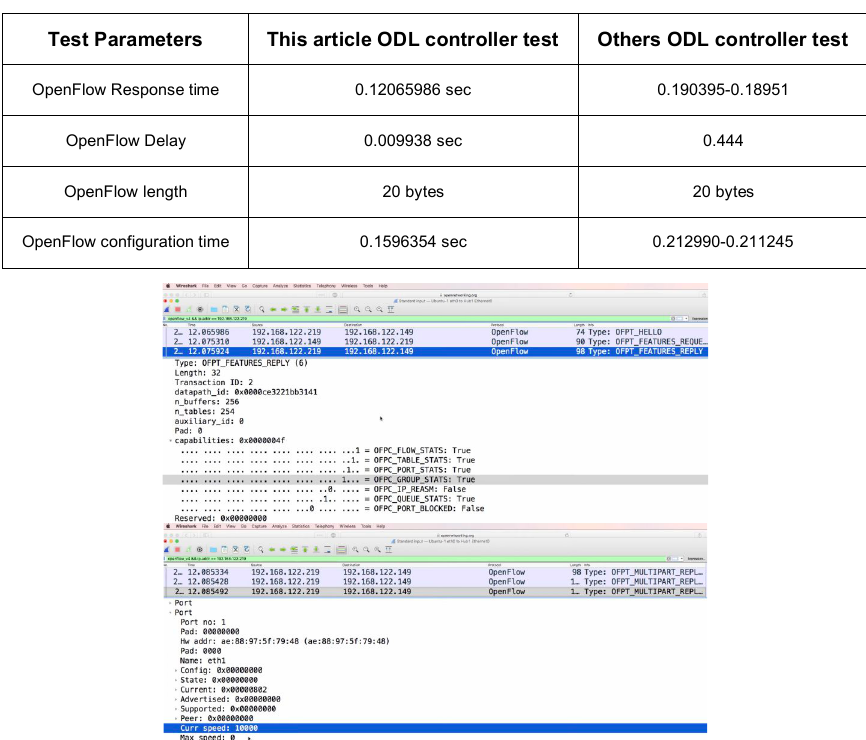
Fig. 4 . Wireshark capturing test parameters